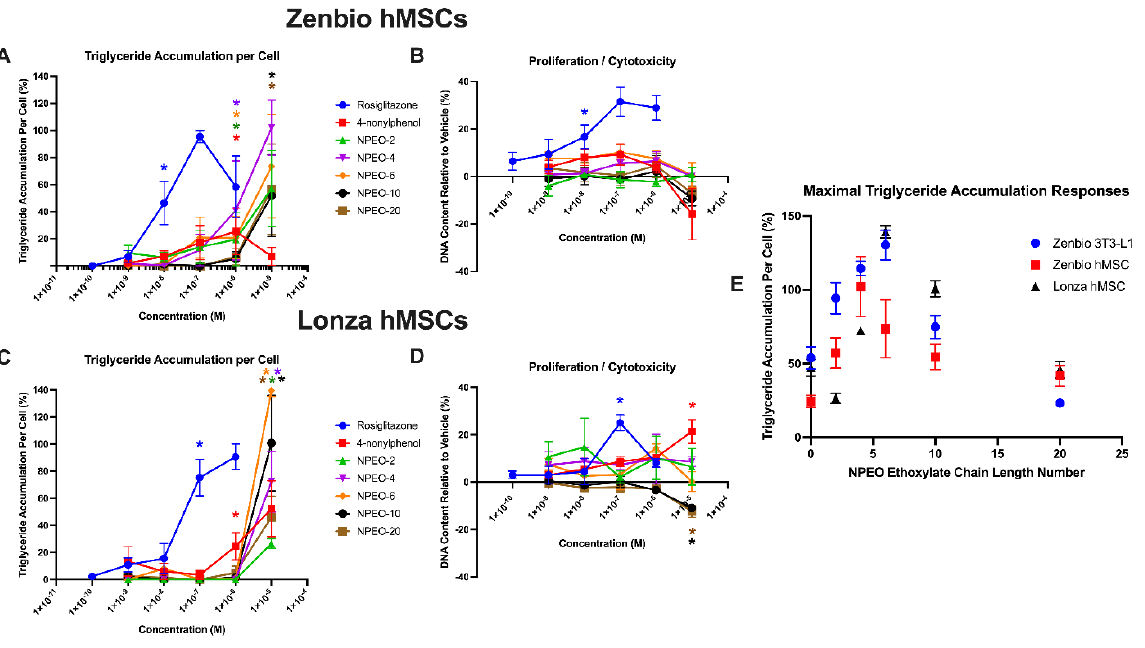
Figure 1. Nonylphenol and polyethoxylates promote adipogenesis in human mesenchymal stem cell models. Zenbio and Lonza human bone marrow – derived mesenchymal stem cell models were differentiated as described in Methods and assessed for adipocyte differentiation (Nile Red staining of lipid accumulation) and cell proliferation (Hoechst staining) after 14/21 (respectively) days of differentiation while exposed to controls chemicals as well as nonylphenol and its ethoxylates. Percent normalized triglyceride accumulation per cell relative to maximal rosiglitazone response (normalized to DNA content) ( A , C ). increase (cell proliferation) or decrease (potential cytotoxicity) in DNA content relative to vehicle control ( B , D ). Zenbio – sourced cell data provided in ( A , B ), and Lonza – sourced cell data provided in ( C , D ). Data presented as mean ± SEM from three independent experiments. * indicates lowest concentration with significant increase in triglyceride over vehicle control or cell proliferation/cytotoxicity relative to vehicle control, p < 0.05, as per Kruskal – Wallis in GraphPad Prism 9. X – axis format is provided in log scale. Panel ( E ) provides a summary plot of maximal effects on triglyceride accumulation based on ethoxylate chain length across cell models, comparing results from panels ( A , C ) with previously published effects in 3T3 – L1 cells (PMID: 29106673). NPEO = nonylphenol polyethoxylated (with varying average ethoxylate chain lengths).